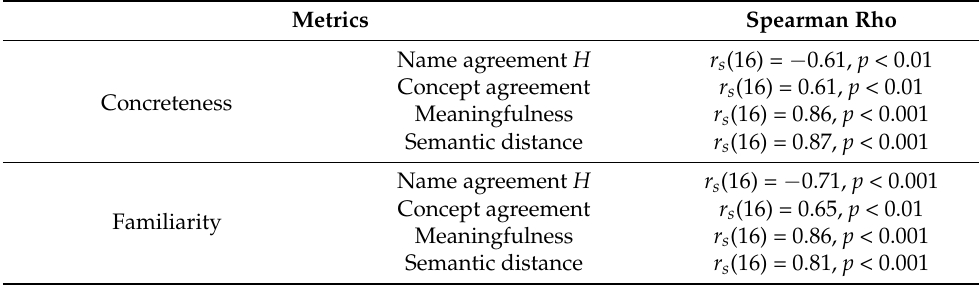
Table 3. Computed spearman rank